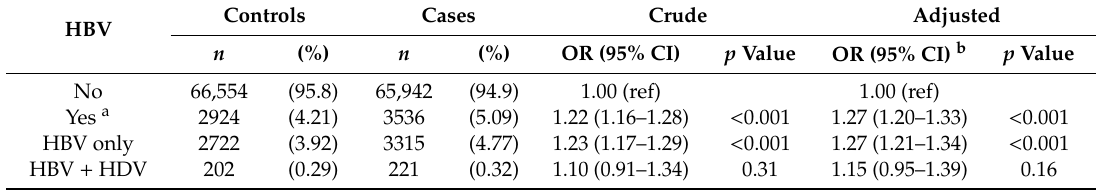
Table 2. Comparison of chronic hepatitis B virus infection between colorectal cancer cases and controls.